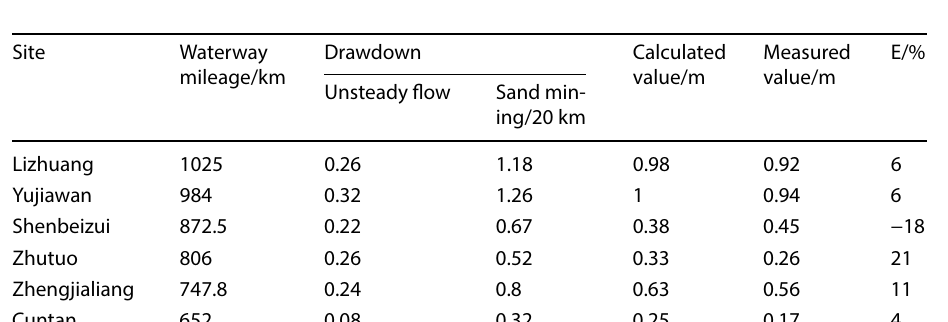
Fig. 27 The relationship between the water level and discharge at the Zhutuo hydro- logical